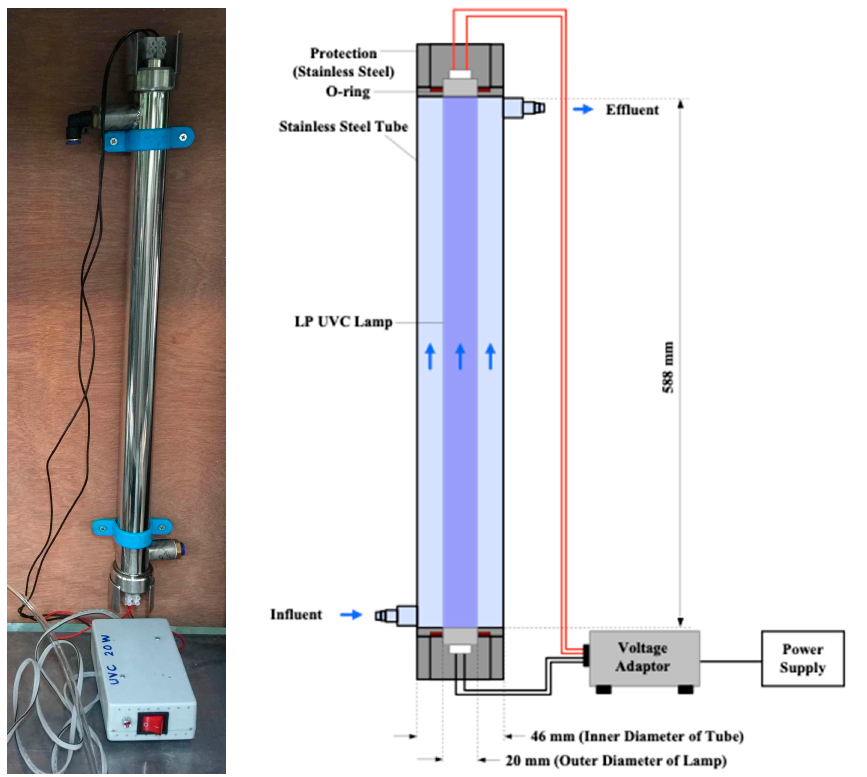
Figure 2. Photo and schematic of the flow-through low-pressure UV reactor constructed in-house in Thailand.